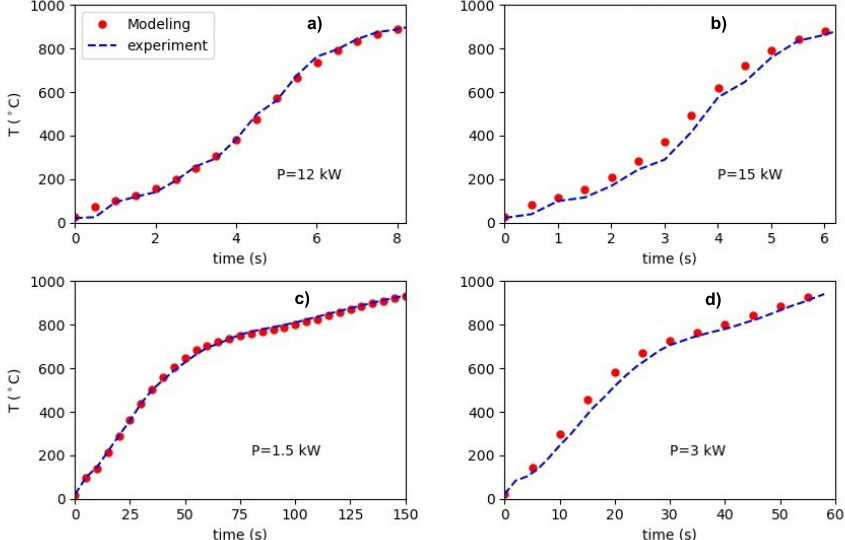
Figure 6. ( a ) Testing the model on the 12 kW measurements using the calibrated model from the 13.5 kW experiment. ( b ) Testing the model on the 15 kW measurements using the calibrated model from the 13.5 kW experiment. ( c ) Testing the model on the 1.5 kW measurement using the calibrated model from the 2.1 kW experiment. ( d ) Testing the model on the 3 kW measurement using the calibrated model from the 2.1 kW experiment.